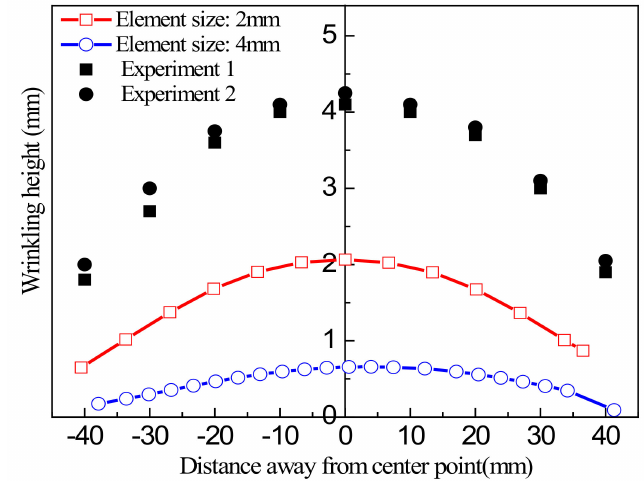
Figure 21. Comparison of simulation results using the S4R linear element and the dynamic algorithm with experimental